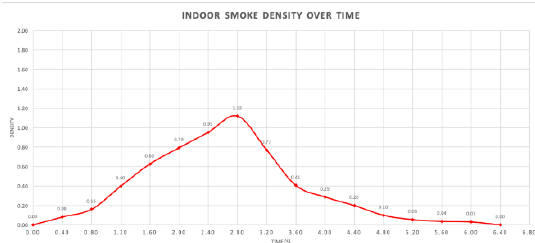
Figure 10. 2D Graph of Cigarette Smoke Density vs Time in an Indoor Environment